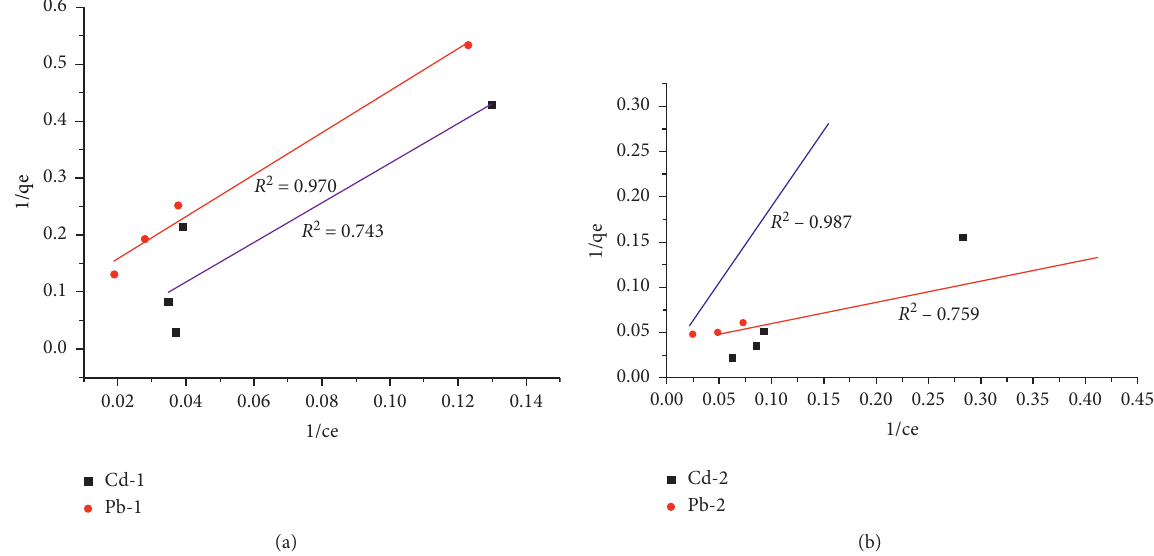
Figure 5: Langmuir isotherm for Cd (II) and Pb (II) adsorption on clay-1 (a) and clay-2 (b).